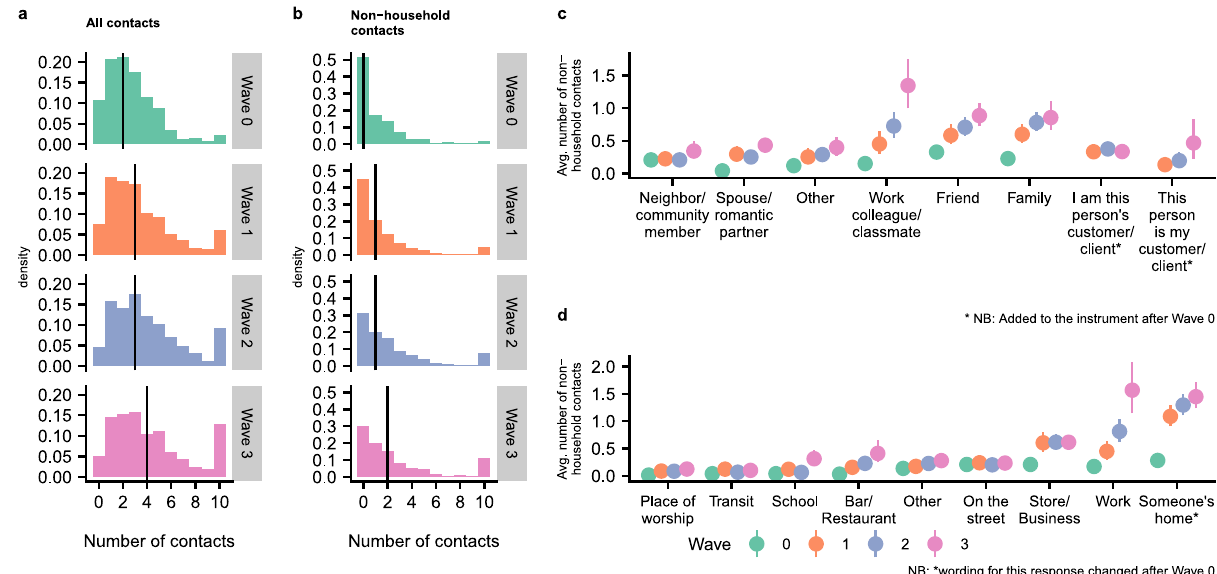
Fig. 1 Reported interpersonal contact across four survey waves. a , b Histograms of reported number of contacts ( a ) and non-household contacts ( b ) among respondents for each wave. Reported contacts are topcoded at 10 in these plots. The vertical lines show the median number of contacts. c , d Estimated average number of non-household contacts each person reported to have taken place by contact ’ s relationship ( c ) and location ( d ) based on n = 29,880 reports about detailed contacts ( “ Methods ” ). Uncertainty estimates are 95% intervals derived from the bootstrap. Each point shows estimated average numbers of non-household contacts in each category, per person. For example, Panel c shows that the average respondent reported almost 0.8 non-household contacts with family members in Wave 2. Avg.